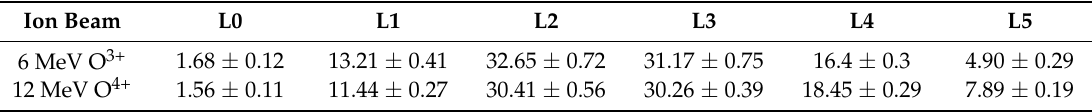
Figure 4. High resolution particle induced X-ray emission (HR-PIXE) spectra of Si K α L N X-rays from thin a-SiO 2 film irradiated by ( a ) 6 MeV O 3+ and ( b ) 12 MeV O 4+ ion beam; ( c ) Relative intensities of K α L N X-rays depending on the number of spectator holes in the L -shell. Table 2. Relative intensities of K α L N X-rays for 6 MeV O 3+ and 12 MeV O 4+